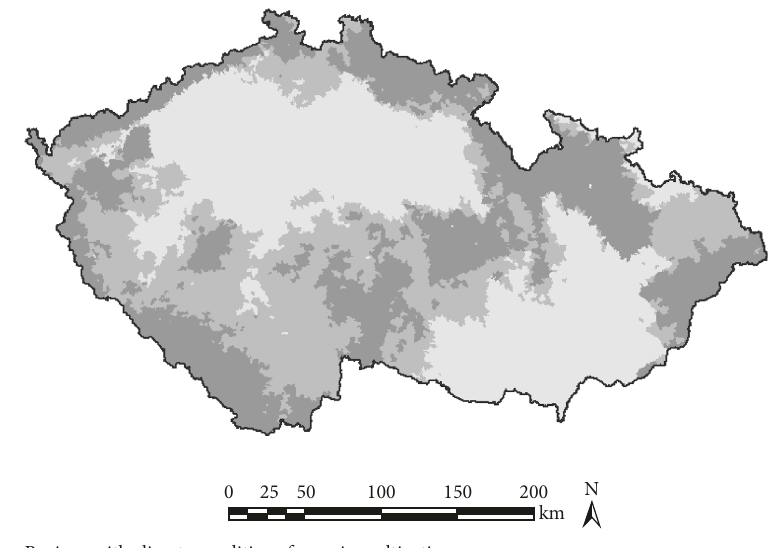
Figure 5: Prediction scenario of climate conditions for grain maize growing in the study region of the Czech Republic in the period 2051–2070, based on the regional biogeographical model.